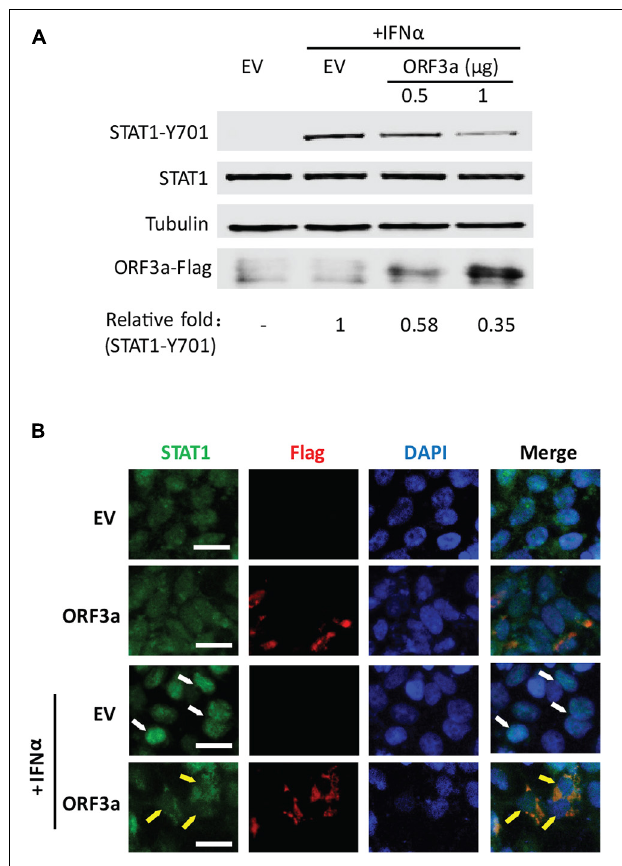
FIGURE 2 | ORF3a dampens IFN-activated signaling via restraining STAT1 phosphorylation and nuclear translocation. (A) ORF3a inhibits IFN-induced phosphorylation of STAT1 in HEK293T cells. Cells were transfected with 0.5 or 1 µ g of ORF3a plasmid. Forty-eight hours later, the cells were stimulated with IFN α at 500 U/mL for 0.5 h, then harvested for immunoblotting with antibodies against STAT1-Y701, STAT1, tubulin, and Flag. Relative levels of STAT1-Y701 are shown as folds below the images after normalization with tubulin. (B) ORF3a restrains nuclear translocation of STAT1. The transfected cells were treated with IFN α for 0.5 h and then fixed with paraformaldehyde for immunofluorescence assay with antibodies against STAT1 (green) and Flag (red). DAPI staining of nuclear DNA is also shown. Arrows were added to show the STAT1 in the nucleus (white) or cytoplasm (yellow). Bars in images denote 20 µ